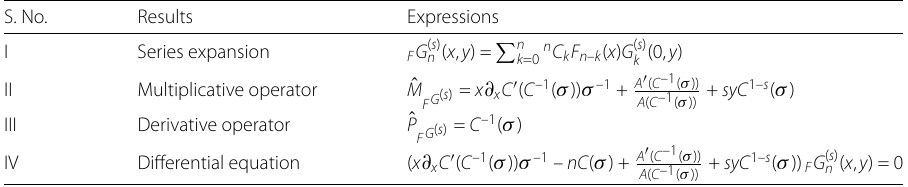
Table 4 Results for Boas–Buck–Gould–Hopper polynomials F G ( s ) n ( x , y ) S.